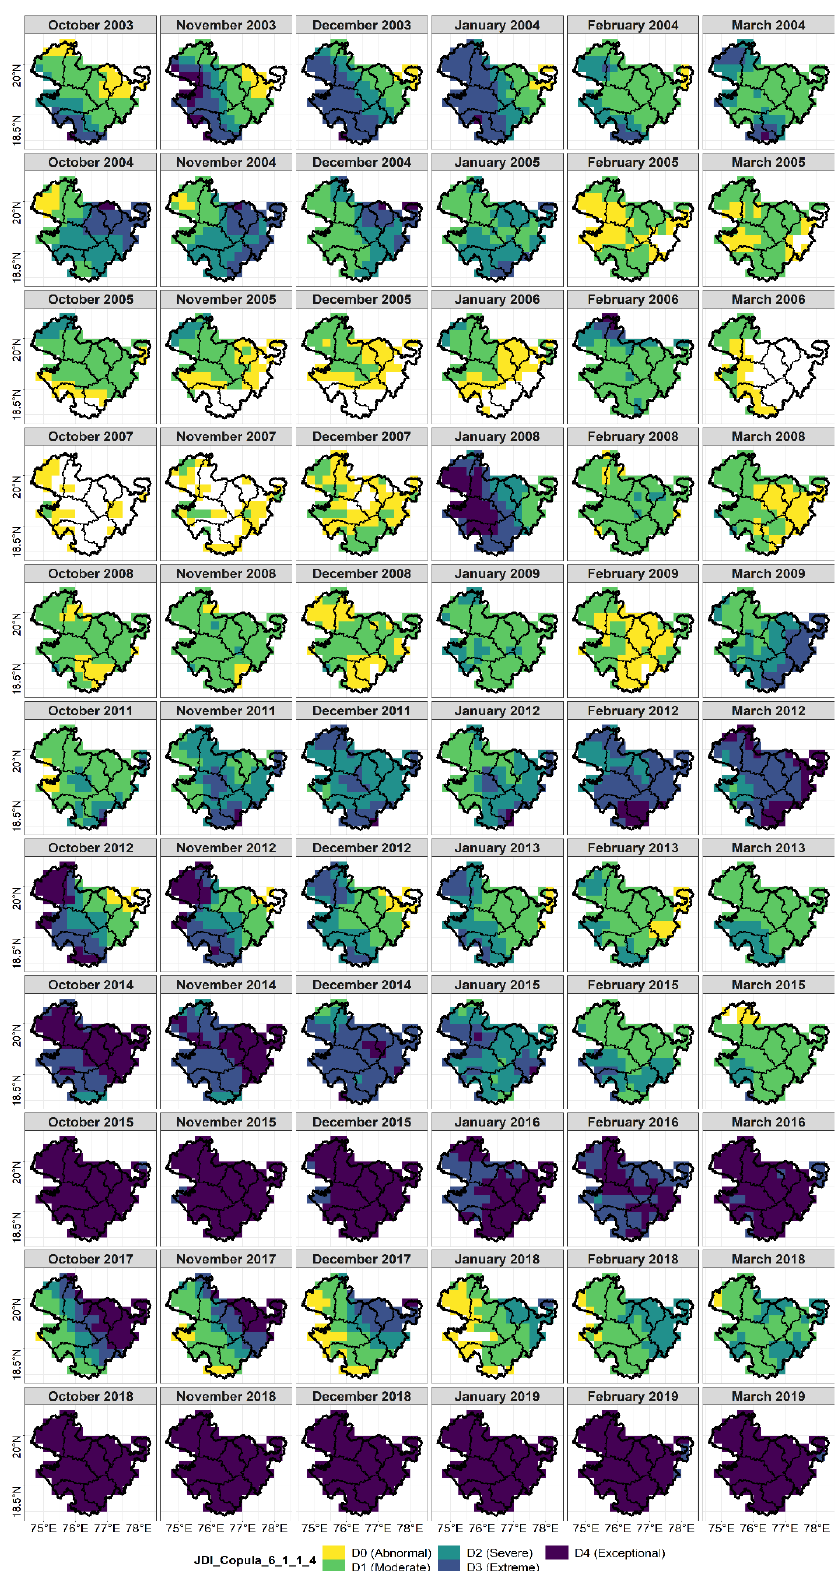
Figure 9. Spatial distribution of drought severity over Marathwada in Rabi season of different drought years detected by using JDI_Copula.